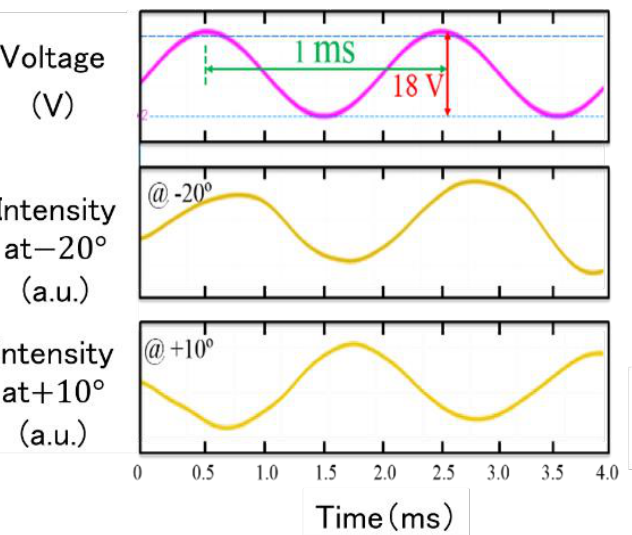
Figure 8. Integrated phase controller consisting of a silica-based planar lightwave circuit; photo- graph ( left ) and schematic configuration ( right ).